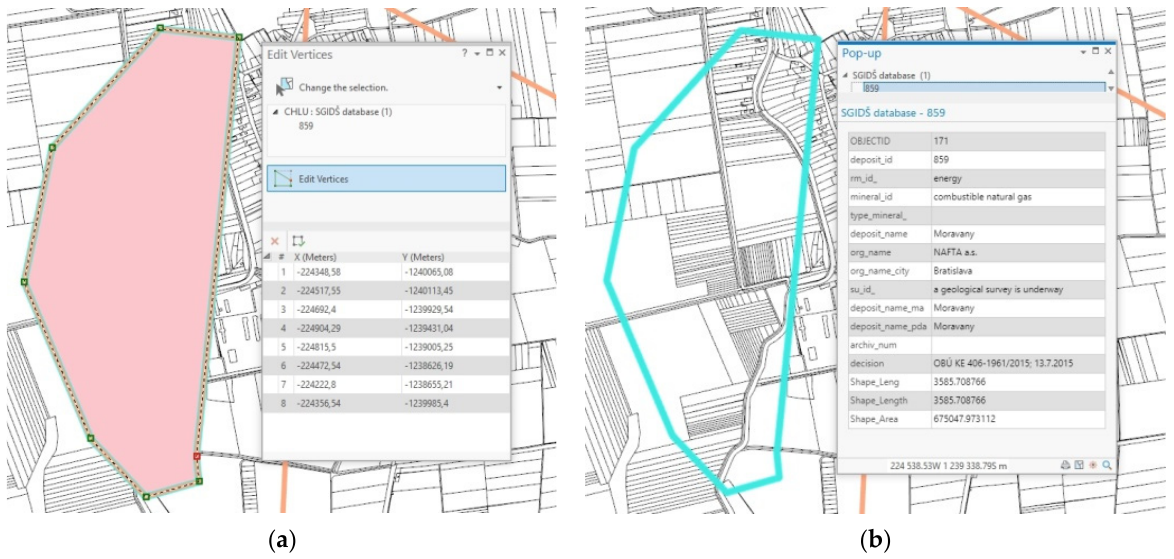
Figure 5. Representation of the method of recording PDA from Geo IS in the GIS environment: ( a ) breakpoint coordinates; ( b ) attribute table.